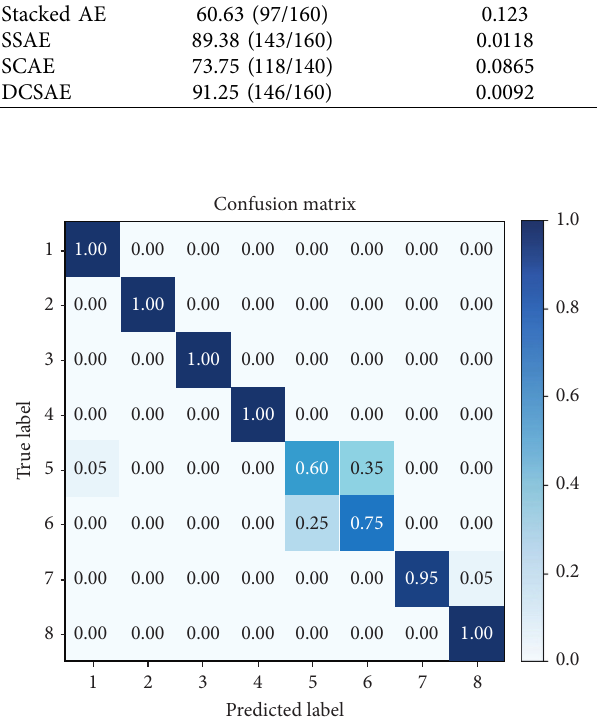
Table 6: Diagnosis results of four different methods. Method